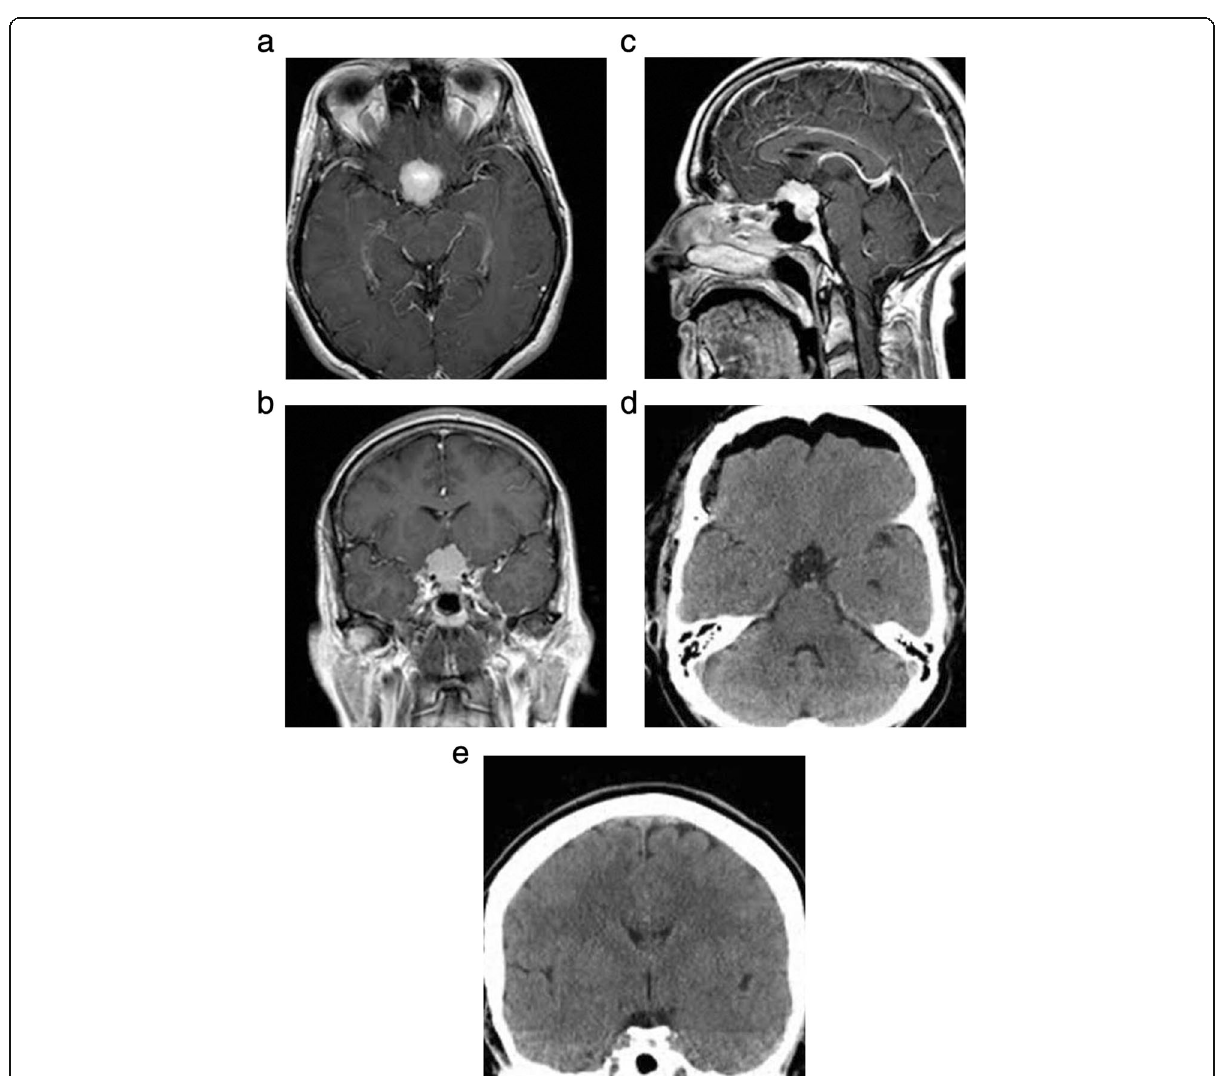
Fig. 4 A case of tuberculum sellae meningioma successfully operated on through right-side lateral supraorbital approach. Preoperative axial ( a ), coronal ( b ), and sagittal ( c ) MRI views show tuberculum sellae meningioma. Postoperative CT axial ( d ) and coronal ( e ) views show complete removal of the